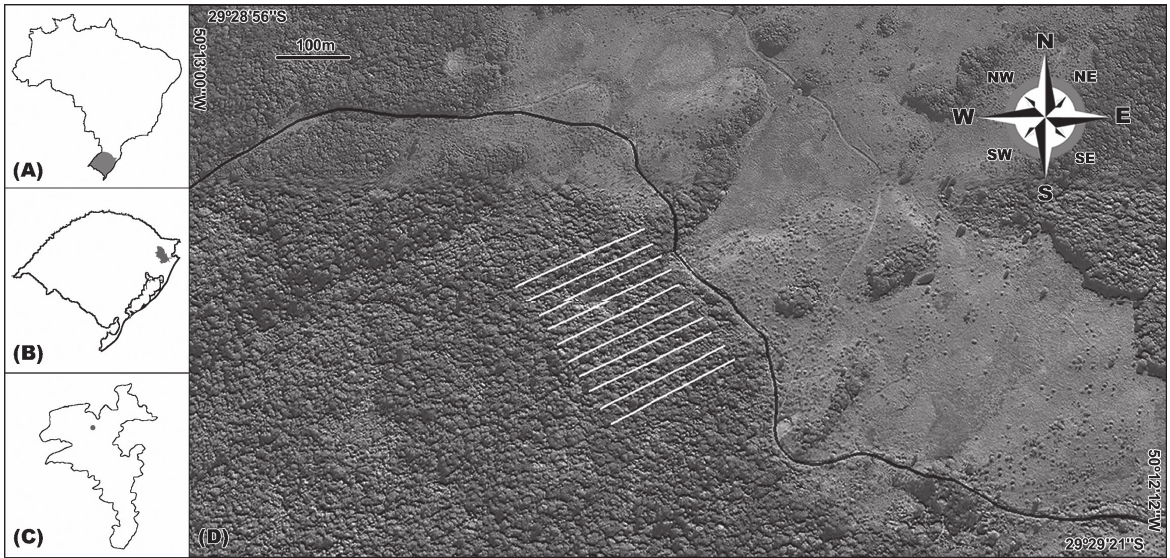
Fig. 1 - Study area. (A) Brazilian map, with the state of Rio Grande do Sul in gray; (B) Map of the state of Rio Grande do Sul, with the area of São Francisco de Paula city in gray; (C) Total area of the Pró-Mata, with gray point indicating the sampling area; (D) Satellite photographic image of the sampling grid (white lines represent the lines of the grid and black line represent the road). Font: Google Earth 6.1.0.5001 (captured on 18 July